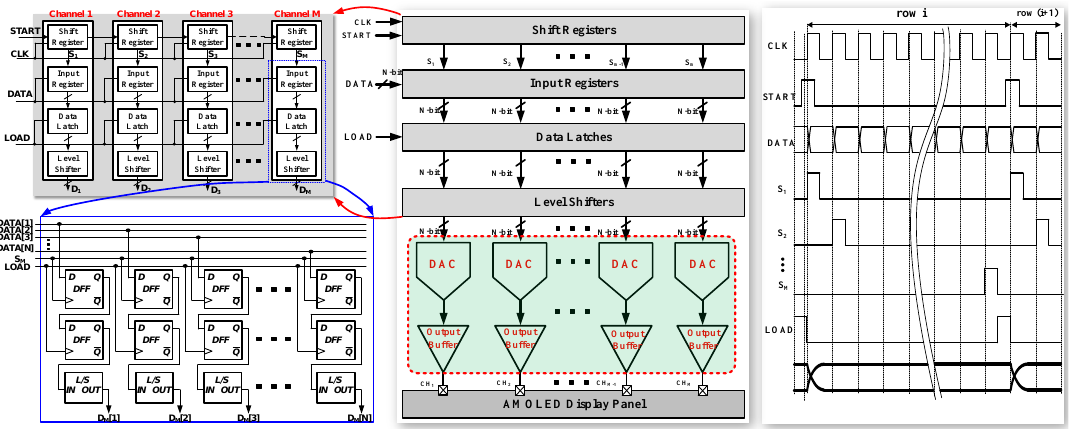
Figure 1. The architecture of active-matrix organic light-emitting diode (AMOLED) column driver.